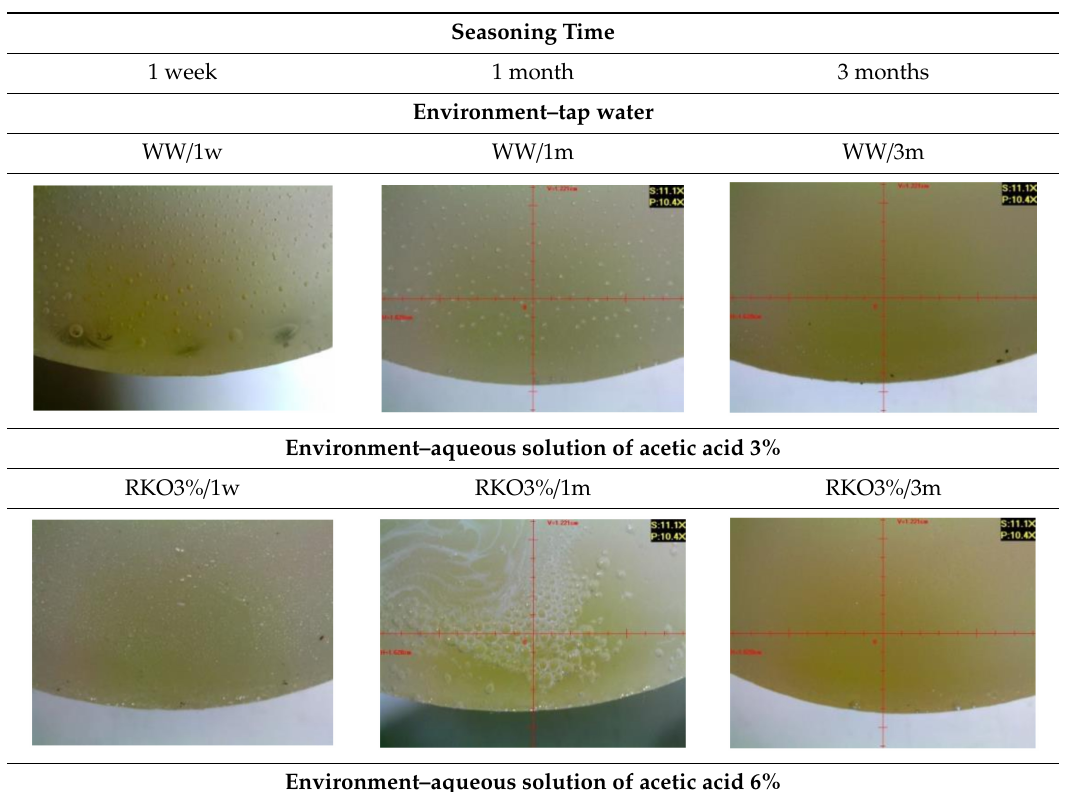
Table 6. Microscopic images of the modified epoxy compound seasoned in exploitation environments (10 ×